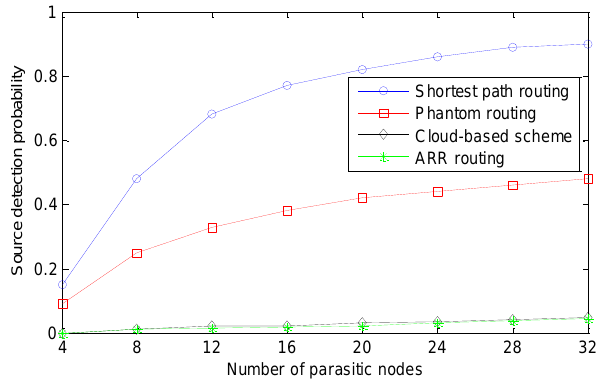
Figure 10. Source detection probability with different numbers of parasitic nodes.